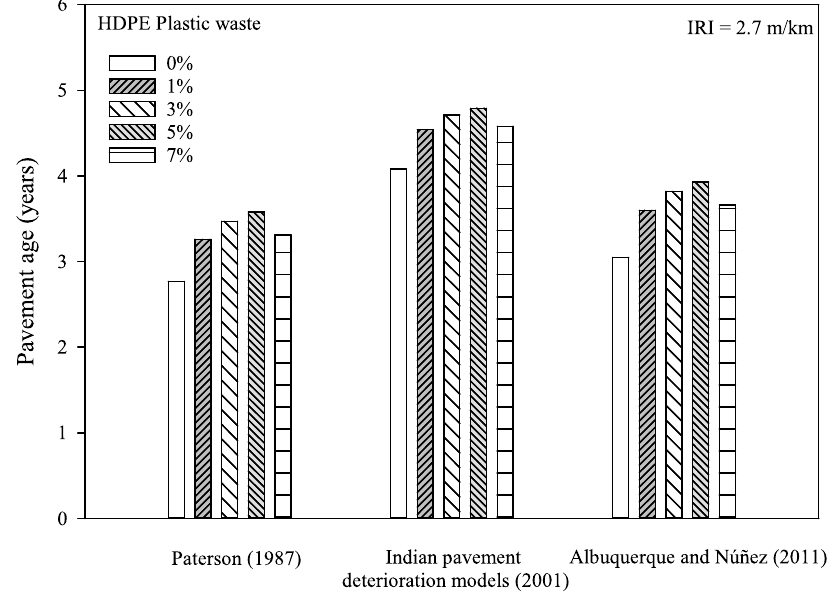
Figure 7. The pavement age of HDPE-ACP at different models.